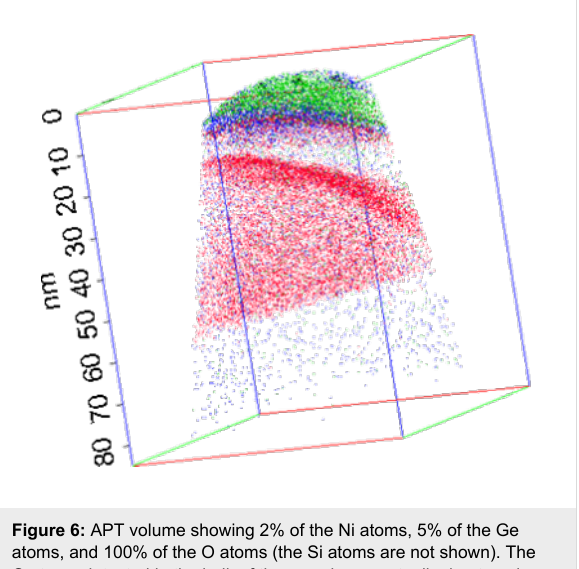
Figure 6: APT volume showing 2% of the Ni atoms, 5% of the Ge atoms, and 100% of the O atoms (the Si atoms are not shown). The O atoms detected in the bulk of the sample are actually due to noise.